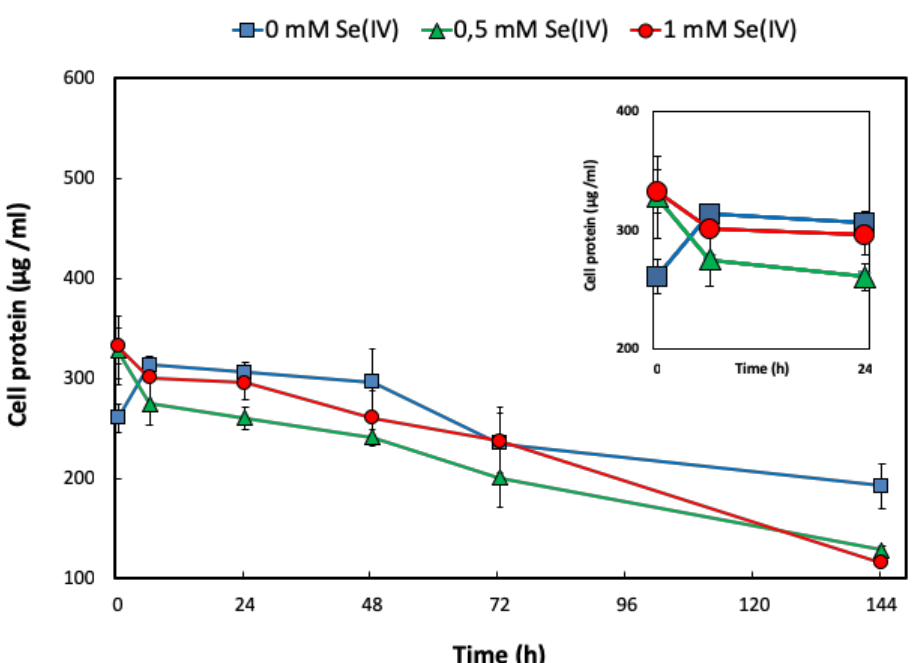
Figure 1. Anaerobic growth curves of S. bentonitica in an R2A* medium with sodium acetate and sodium nitrate in the presence of different Se IV concentrations (0 to 1 mM). The inset graph shows a magnification of the growth curve in the first 24 h. Data are presented as the averages ± standard errors.